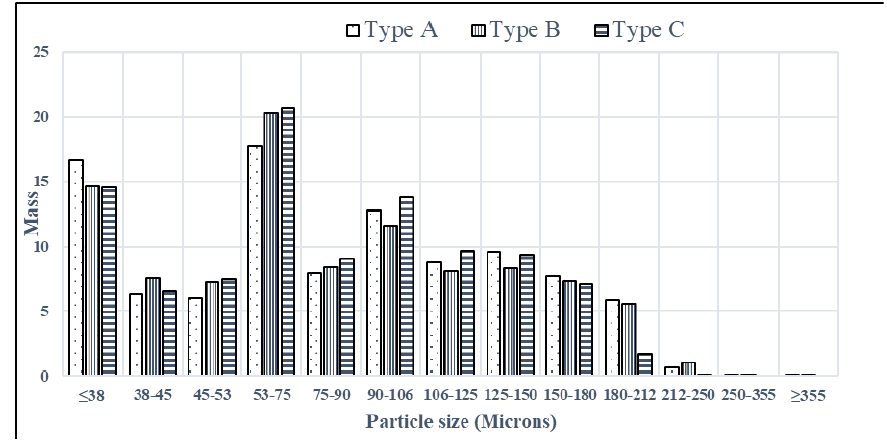
Figure 2. Particle size distribution of pure iron powder.